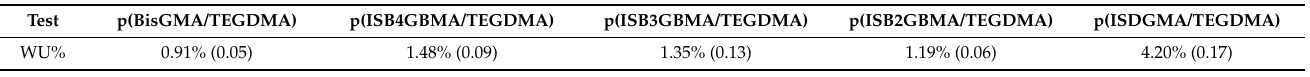
Table 4. Water uptake after 24 h and at 37 ◦ C in DPBS for p(BisGMA/TEGDMA), p(ISB4GBMA/TEGDMA), p(ISB3GBMA/TEGDMA), p(ISB2GBMA/TEGDMA) and p(ISDGMA/TEGDMA). Test p(BisGMA/TEGDMA) p(ISB4GBMA/TEGDMA) p(ISB3GBMA/TEGDMA) p(ISB2GBMA/TEGDMA) p(ISDGMA/TEGDMA) WU% 0.91% (0.05) WU%: water uptake percentage. Standard deviation in parenthesis.